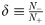
(A) The resolved functional signature and modules structure of a long photoperiod (LP, L16D8) sample. (B) The resolved functional signature and modules structure of a short photoperiod (SP, L8D16). (C) Cluster analysis: plotting the cumulative distribution of the dependencies within the two detected clusters, comparing the two different photoperiods. The upper graph shows cluster 1 and the lower graph cluster 2. C represents the measured averaged correlation of a cluster, and δ≡N-N+ is defined as the contrast ratio of a cluster, measuring the ratio of negative dependencies versus positive dependencies. (D) Inter-cluster analysis: plotting the cumulative distribution of the external dependencies between the two detected clusters, comparing the two different photoperiods. C represents the measured averaged anti-correlation between clusters, and δ≡N+N- is defined as the contrast ratio of a cluster, measuring the ratio of positive dependencies versus negative dependencies.